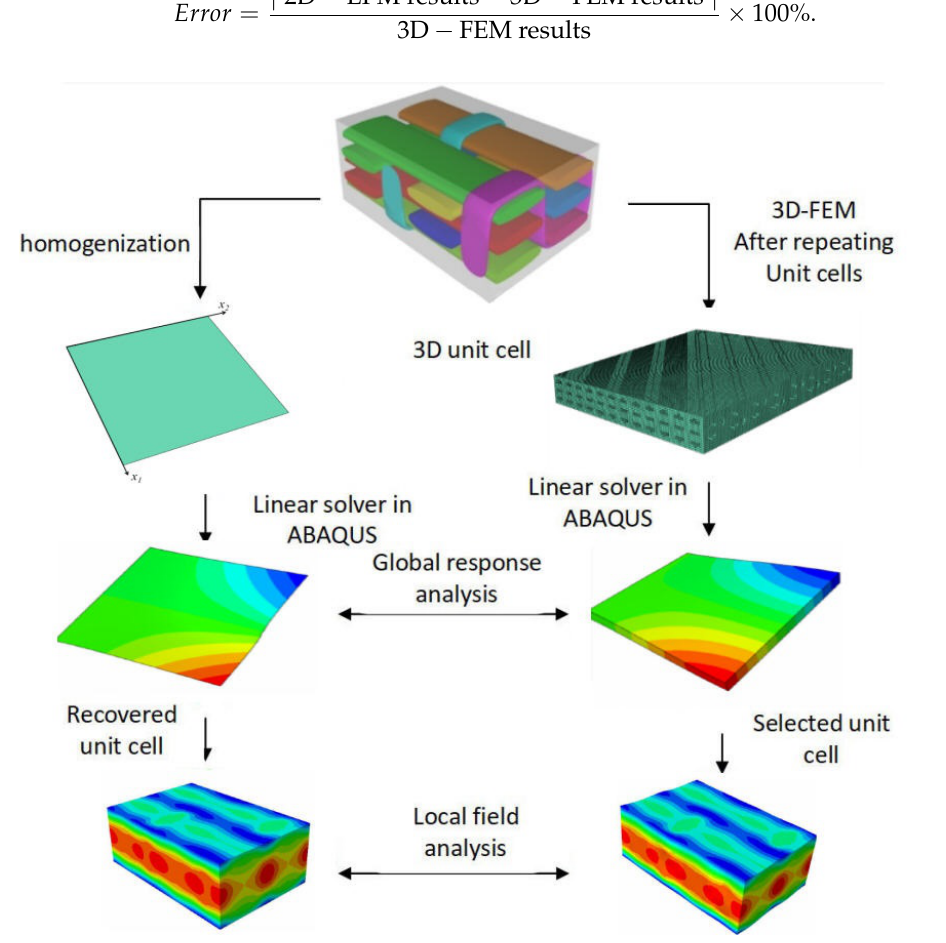
Figure 2. Comparative analysis of 2D-EPM and